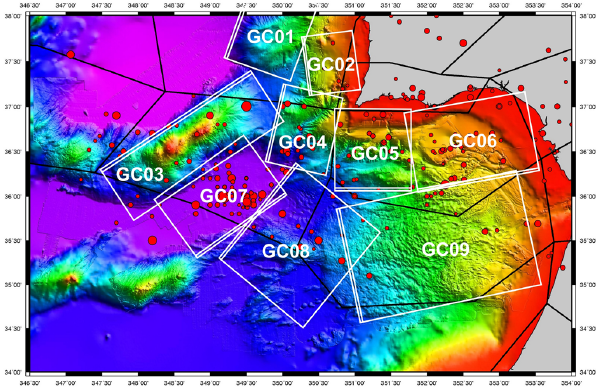
Fig. 3. Main tsunami source areas to be considered in the Gulf of Cadiz (in white). Each rectangle represents a pure thrust fault with the double trace indicating the shallow trace of the fault. For com- parison we show in black the seismic zones recently proposed by the SHARE (Seismic Hazard Harmonization in Europe) project (2012) to be considered for Probabilistic Earthquake Hazard Assessment. The red circles show the instrumental seismicity for M > 4. The data sources are detailed in Sect. 7 of the main